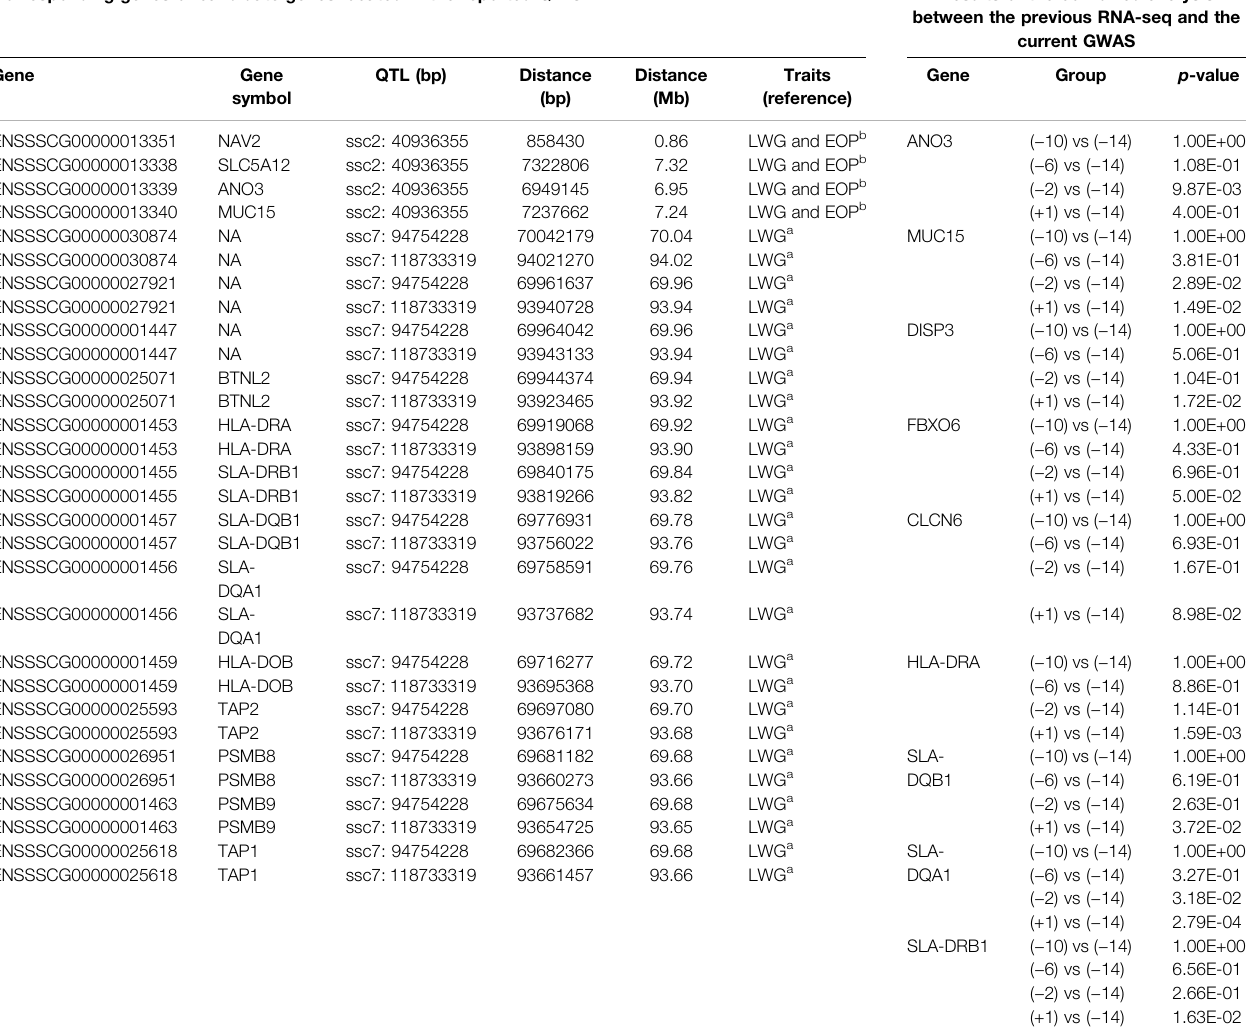
TABLE 3 | Results of the combined analysis with the reported swine mammary gland transcriptome and milk production ability GWAS data. Corresponding genes of candidate genes located in the reported QTLs Results of the combined analysis